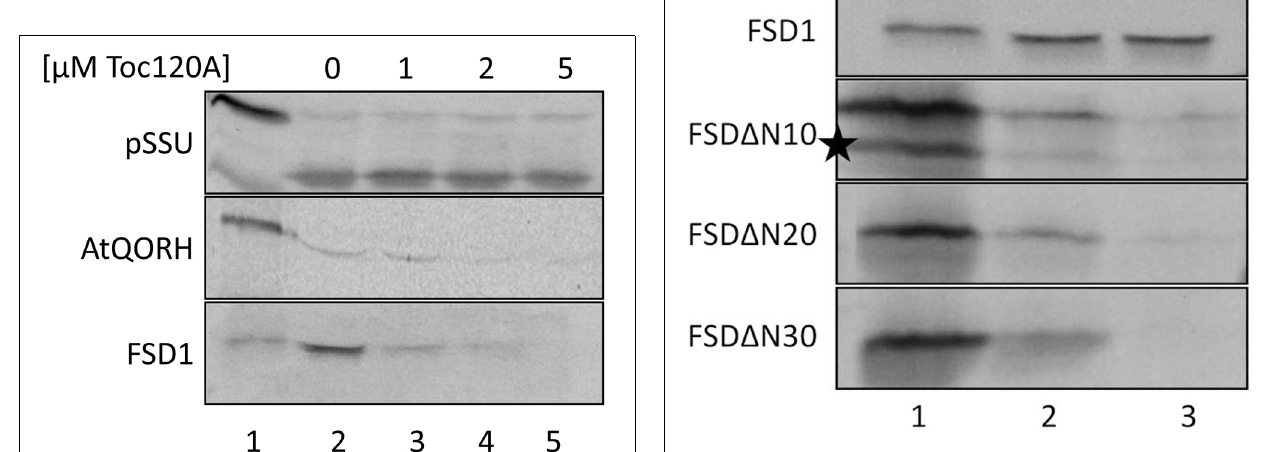
FIGURE 7 | The extreme N-terminus of FSD1 is indispensable for import. In vitro import assays into pea chloroplasts are shown. Lane 1 represents 10% of translation product, Thl ( + ) indicates thermolysin digestion after the import reaction (lane 3). Please note the second band in the translation product of FSD1DN (indicated by an asterisk) which might derive from a downstream methionine recognized in the reticulocyte lysate as an alternative start. Representative results from n = 3 independent experiments are